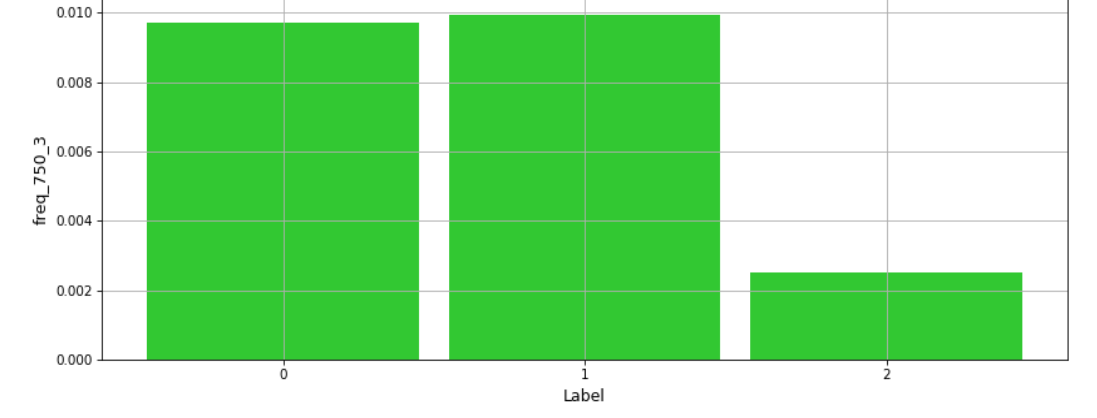
Figure 6. Distribution of frequency-based feature values vs. class labels.